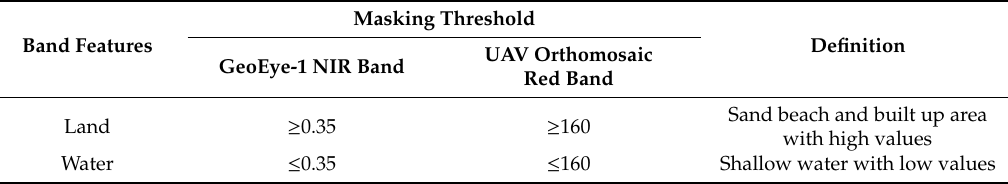
Table 4. Masking out GeoEye-1 NIR and UAV orthomosaic red band based on threshold reflectance values.